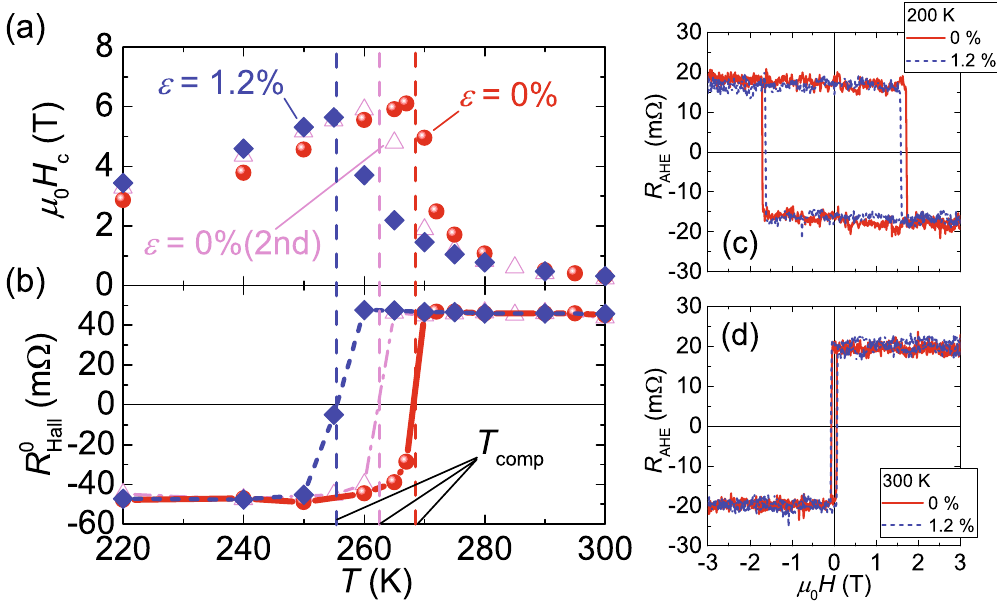
0 Hall ). Results of